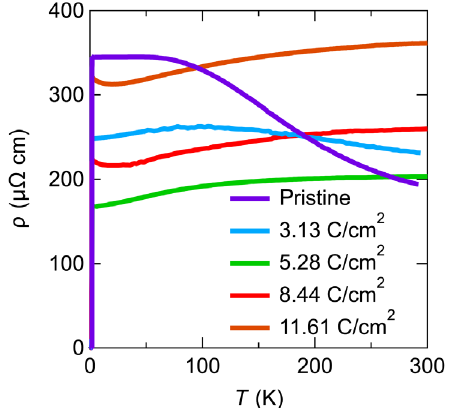
FIG. 7. Temperature dependence of resistivity in LuPdBi before and after irradiation. Zero-field resistivity is shown as a function of temperature in a wide temperature range for pristine (purple), 3.13 (light-blue), 5.28 (green), 8.44 (red), and 11 . 61 C = cm 2 (brown) irradiated